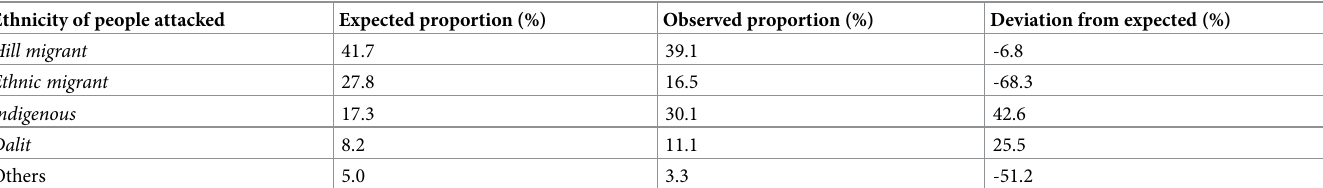
Table 2. The expected and observed proportion of wildlife attacks on humans of different ethnicity. Ethnicity of people attacked